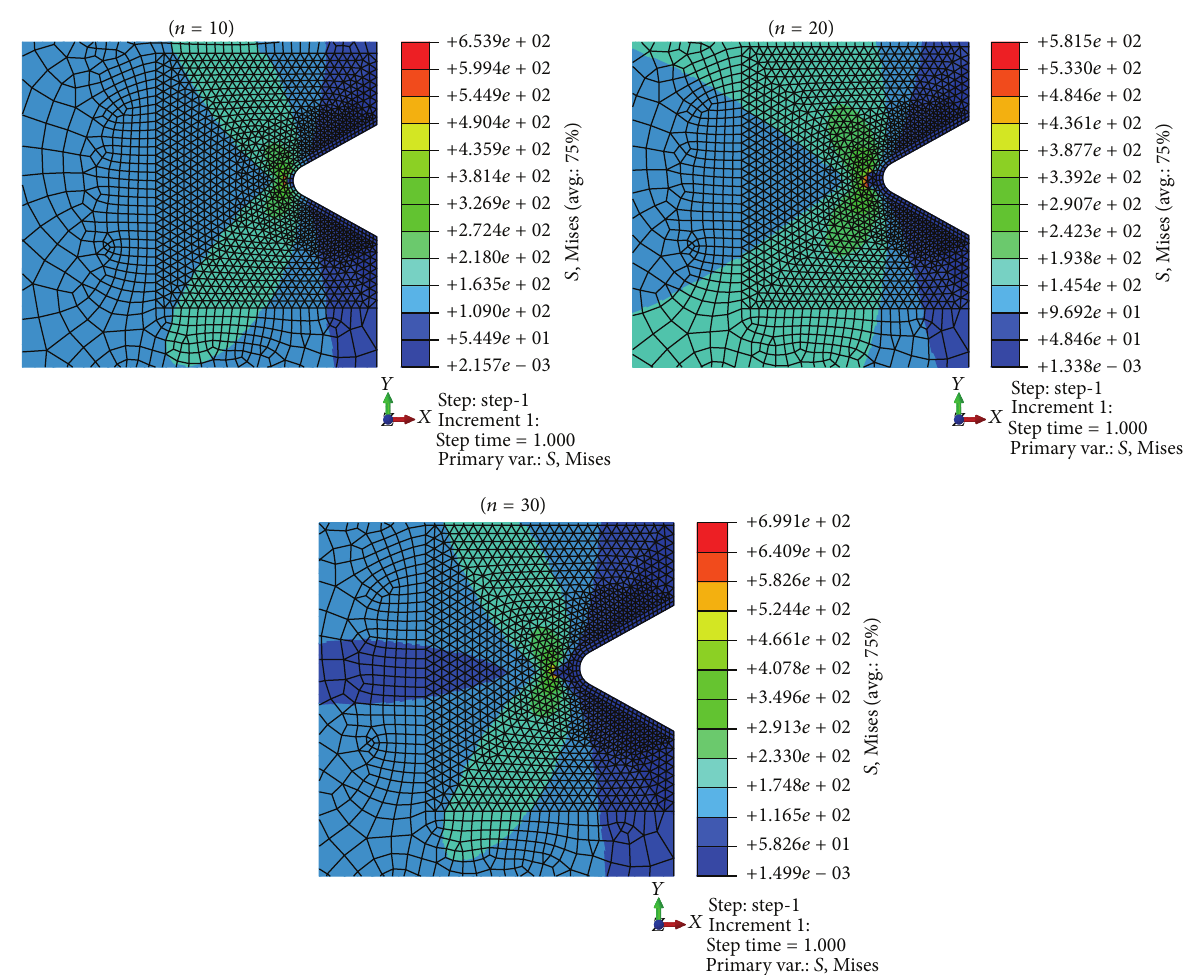
Figure 4: Stress changing of notched specimen during damage evolution.